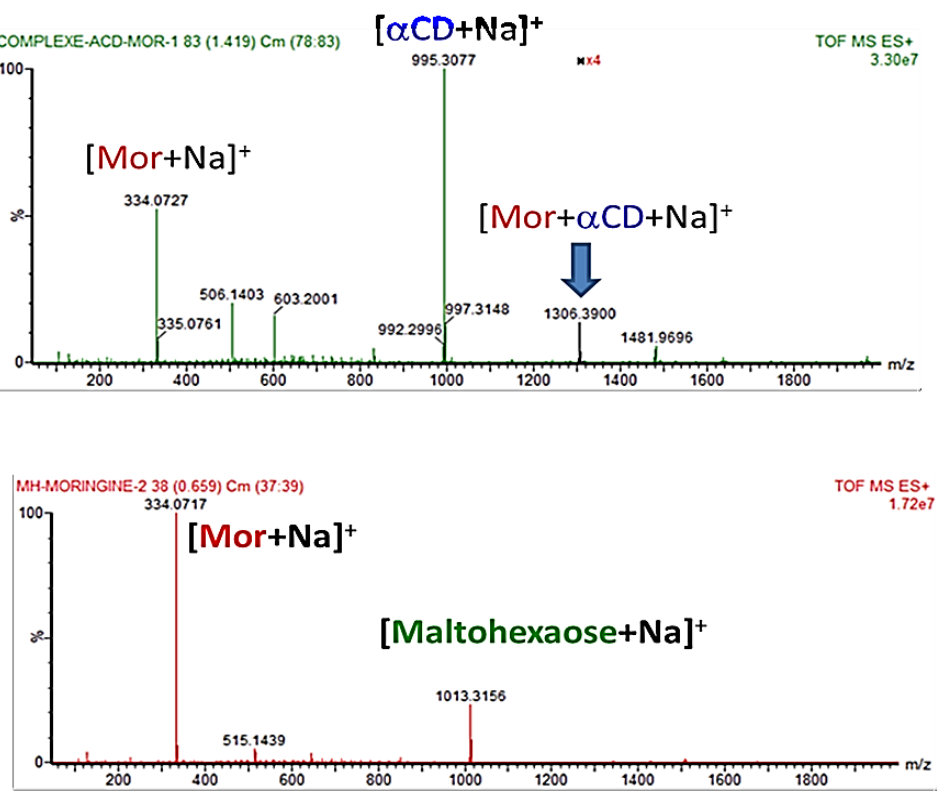
Figure 6. Time-of-flight mass spectrometry (TOF MS) spectra of equimolar mixtures of MH/MOR ( A ) and of α -CD/MOR ( B ) in water (0.5 mM) recorded in positive electrospray ionization mode (ESI + ).